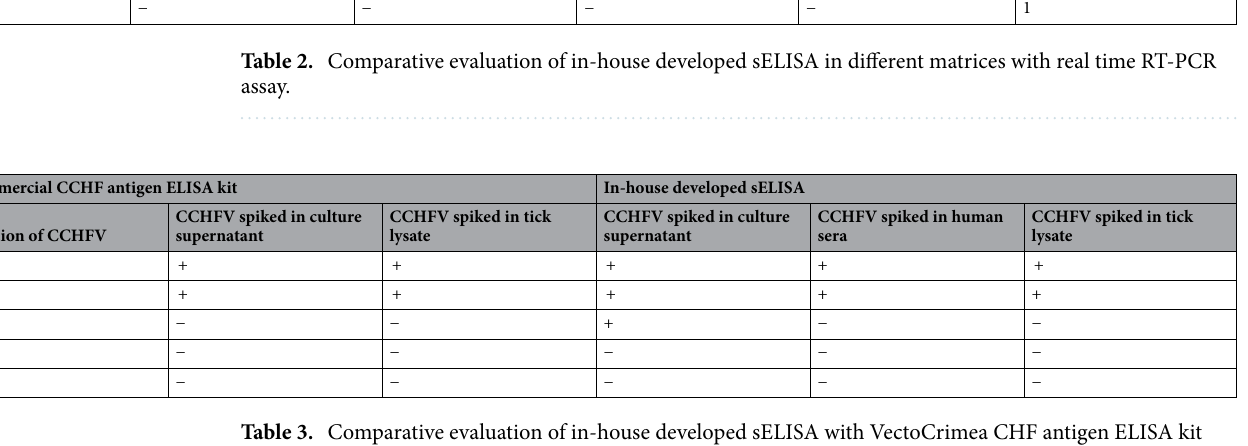
Table 3. Comparative evaluation of in-house developed sELISA with VectoCrimea CHF antigen ELISA kit using different dilutions of inactivated CCHFV in different